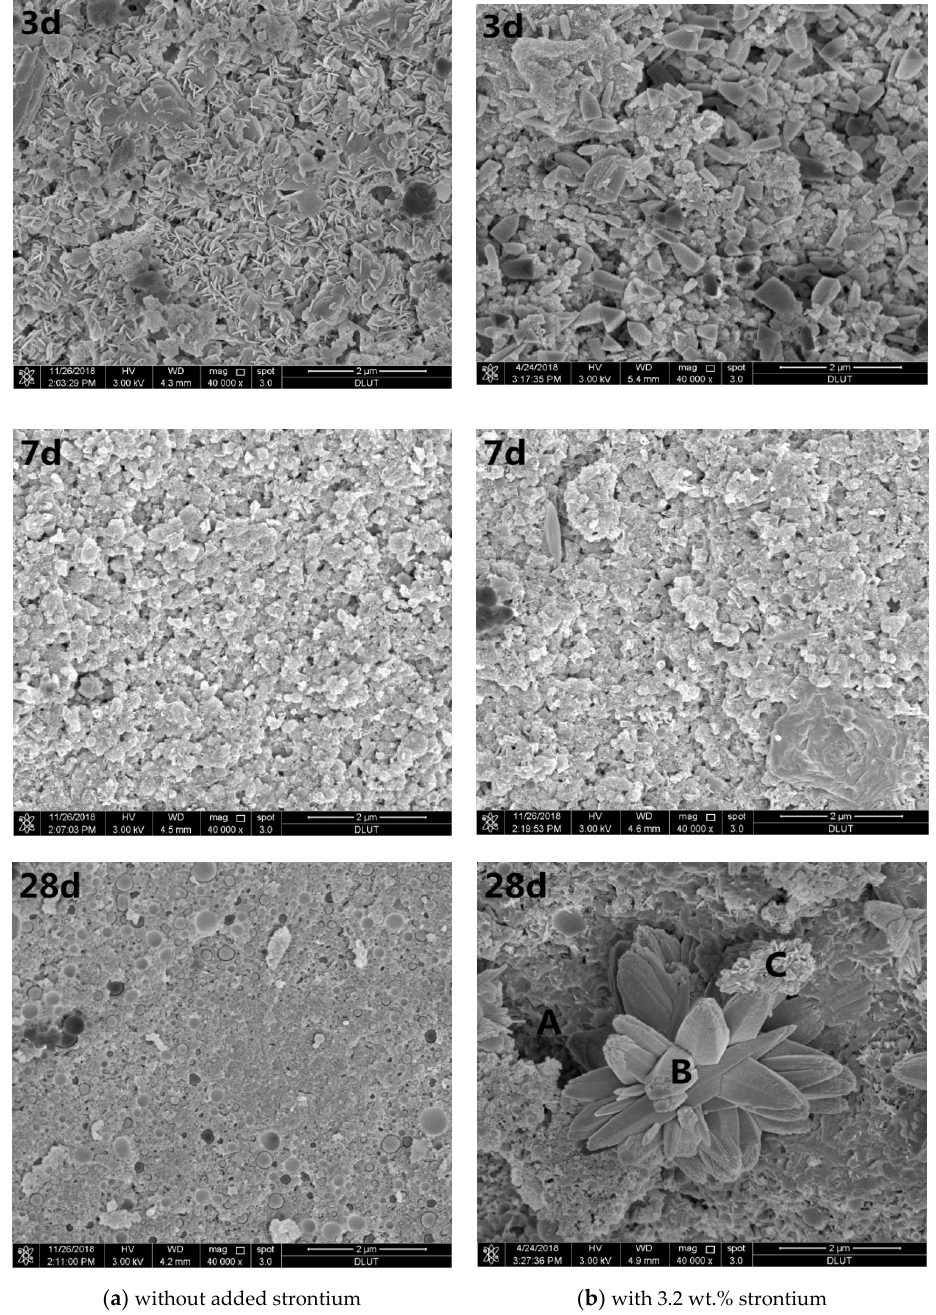
Figure 3. Scanning electron microscopic (SEM) images of different curing periods of the MgO–SiO 2 –H 2 O solidified bodies with or without strontium; ( a ) without added strontium; ( b ) with 3.2 wt.% strontium.